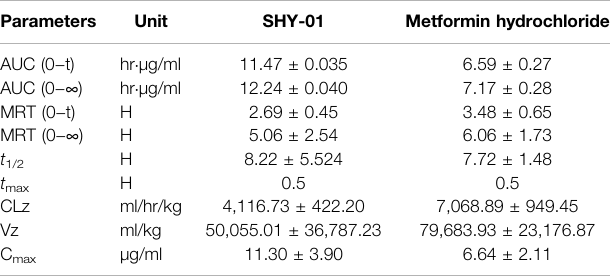
TABLE 1 | The pharmacokinetic pro fi les of SHY-01 in rats with i.p. administration of 50 mg/kg metformin threonate (SHY-01) or metformin hydrochloride.